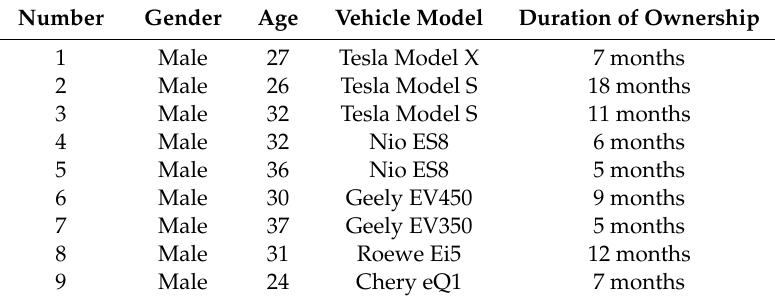
Table 2. Profile of respondents.